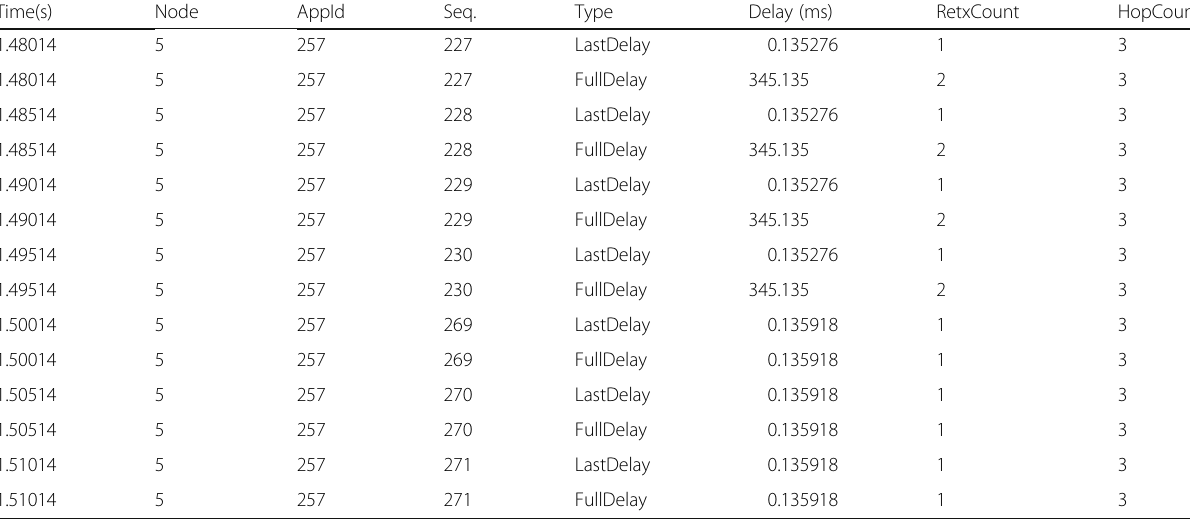
Table 2 Transmission delay in the V2R